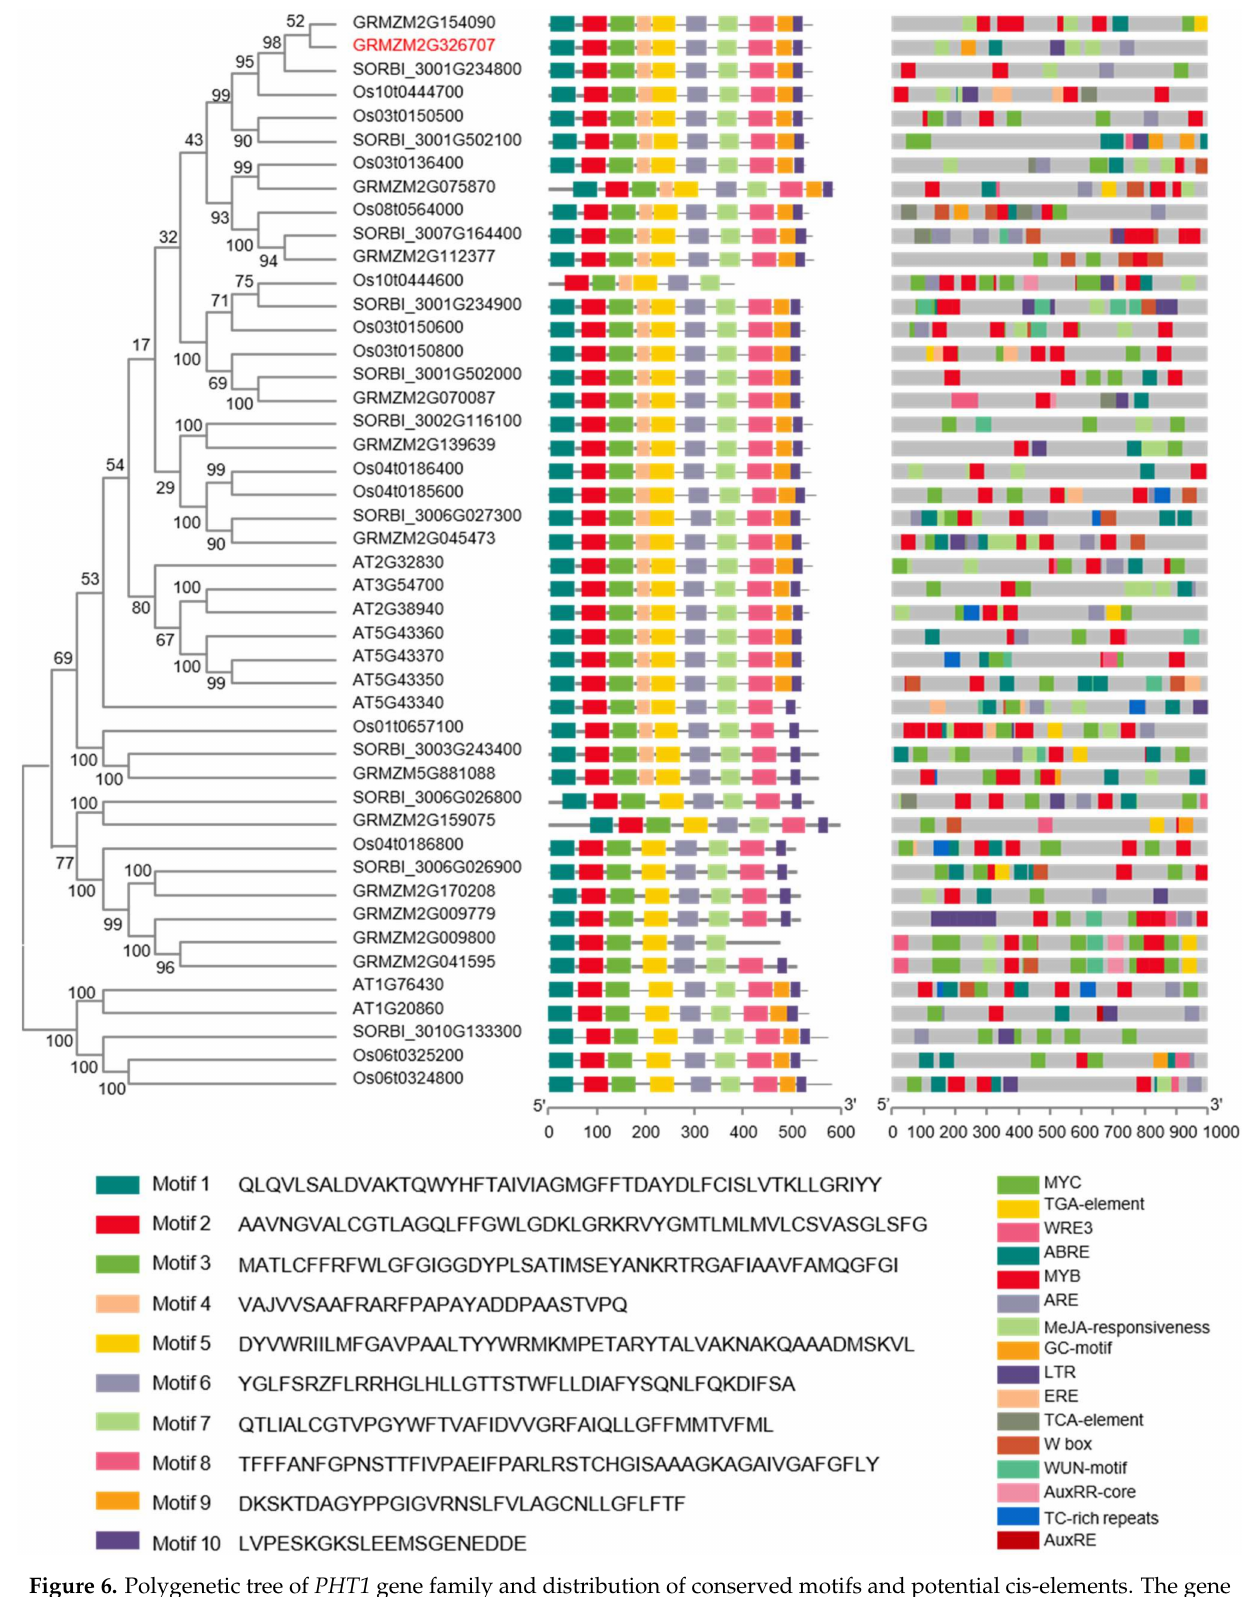
Figure 6. Polygenetic tree of PHT1 gene family and distribution of conserved motifs and potential cis-elements. The gene GRMZM2G326707 ( ZmPHT1;1 ) in red was identified in our GWAS